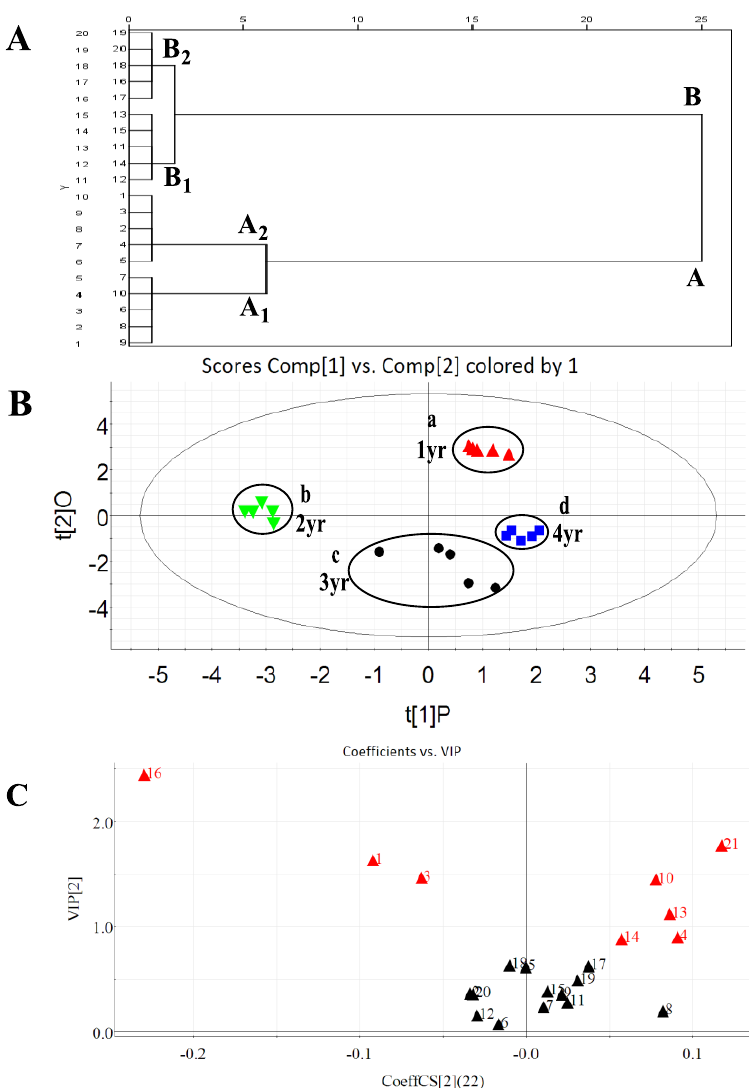
Figure 4. ( A ) HCA of different growth years of P quinquefolium ; ( B ) PLS-DA score of different growth years of P. quinquefolium ; ( C ) VIP plot of the 22 ginsenosides based on